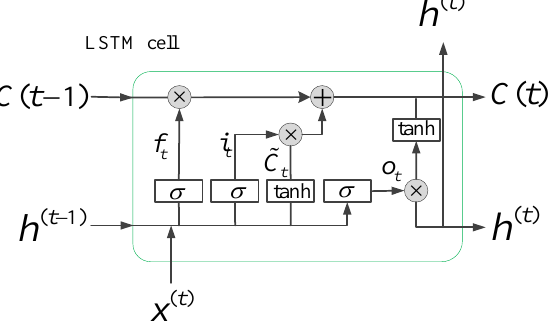
Figure 3. Internal structure of a long short-term memory (LSTM) cell.